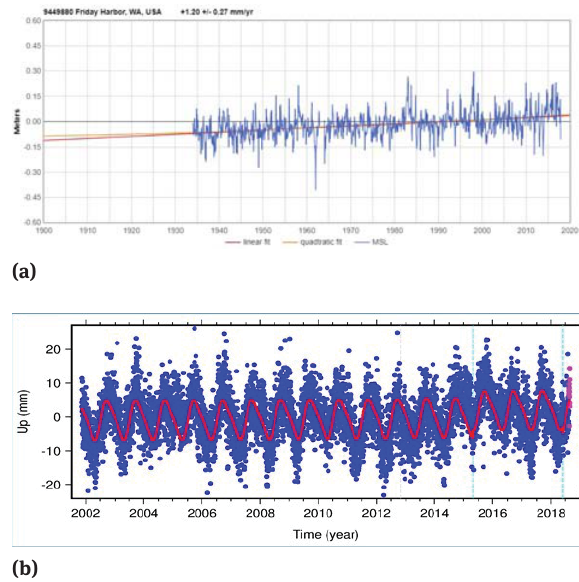
Figure 11: (a) MSL data for Tofino, Canada. Image reproduced mod- ified after [4]. (b) GNSS time series for TFNO. Image reproduced modified after NGL. This GNSS antenna is almost co-located with the tide gauge.